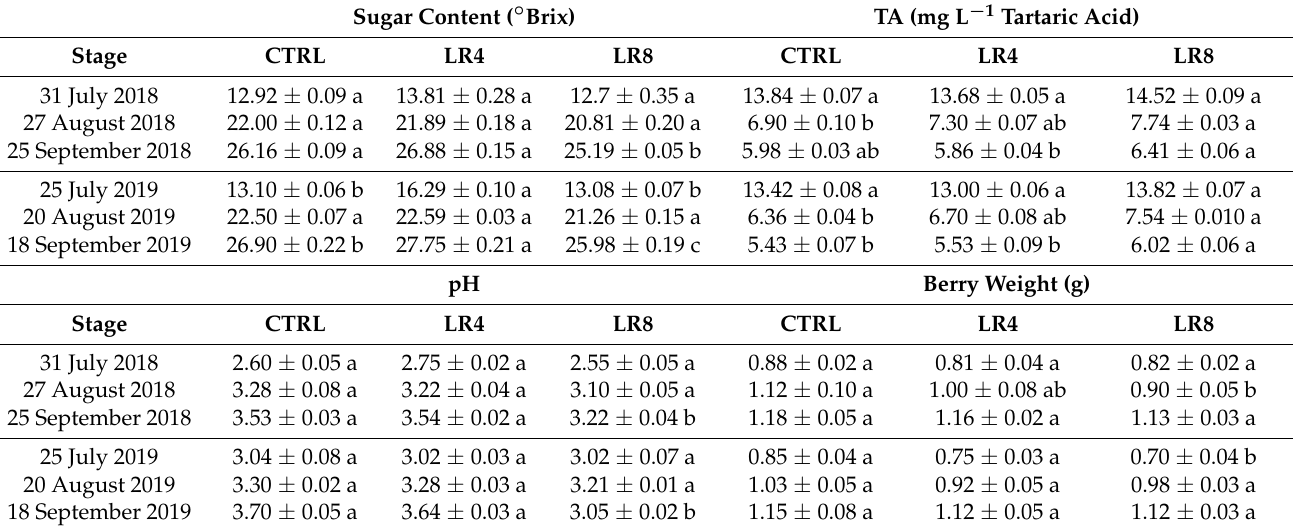
Table 3. Technological maturity. Sugar content ( ◦ Brix), titratable acidity (TA), pH and berry weight of V. vinifera treated with three different defoliation managements: four leaf removal (LR4), eight leaf removal (LR8), and no defoliation (CTRL). Measurements were conducted at full veraison (31 July 2018 and 25 July 2019), mid-maturation (27 August 2018 and 20 one-way ANOVA. Different letters within the same parameter and row indicate significant differences (LSD test, p ≤ 0.05). Sugar Content ( ◦ Brix) TA (mg L − 1 Tartaric